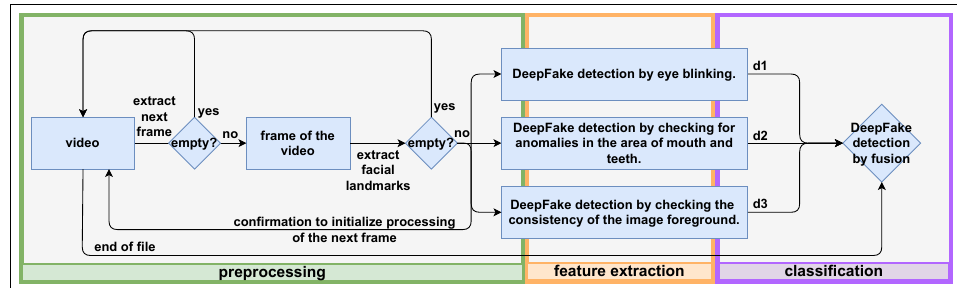
Figure 2. Concept pipeline considered in this